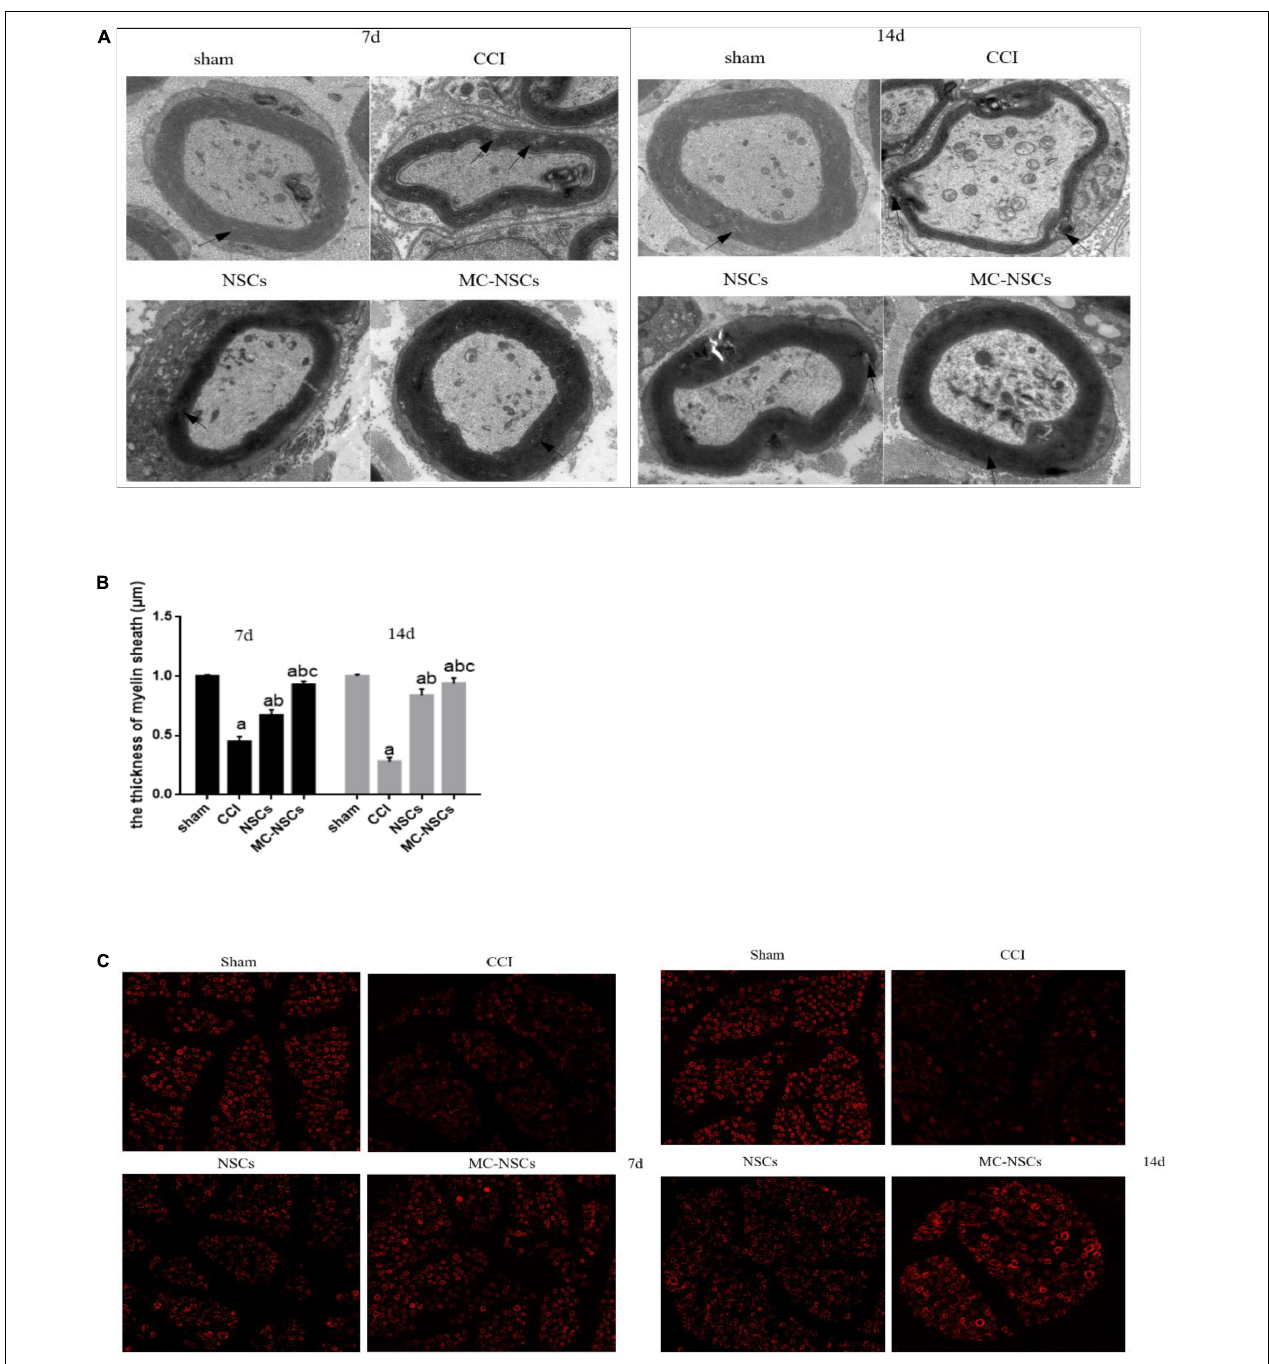
FIGURE 2 | On days 7 and 14 after surgery, the changes in the sciatic nerve myelin ultrastructure and fluorescence in each group of rats were randomly observed. (A) Electron microscope at × 5,000 magnification. In the sham group, the structure of the myelin sheath of the sciatic nerve was uniform, regular, and clear. However, in the chronic sciatic nerve compression injury (CCI) group, the sciatic nerve fibers had the myelinated lamina separated, segmental, or stratified demyelination changes could be seen in part of the myelin sheath. In the neural stem cell (NSC) group, the myelin sheath of the sciatic nerve was relatively intact, and some demyelination changes could be seen. Compared with the NSC group, in the microencapsulated neural stem cell (MC-NSC) group, the sciatic nerve had more myelinated fibers, the thickness of the myelin sheath was more uniform, and the morphology of the nerve filaments was normal. (B) The thickness of the myelin sheath of the sciatic nerve of each group of rats. Data were expressed as the mean ± SD ( n = 6). (C) At × 400 magnification. Immunofluorescence assay was used to detect the changes in myelin basic protein (MBP) fluorescence in sciatic nerve myelin sheath of rats in each group. a p < 0.05 vs. sham group; b p < 0.05 vs. CCI group; c p < 0.05 vs. NSC